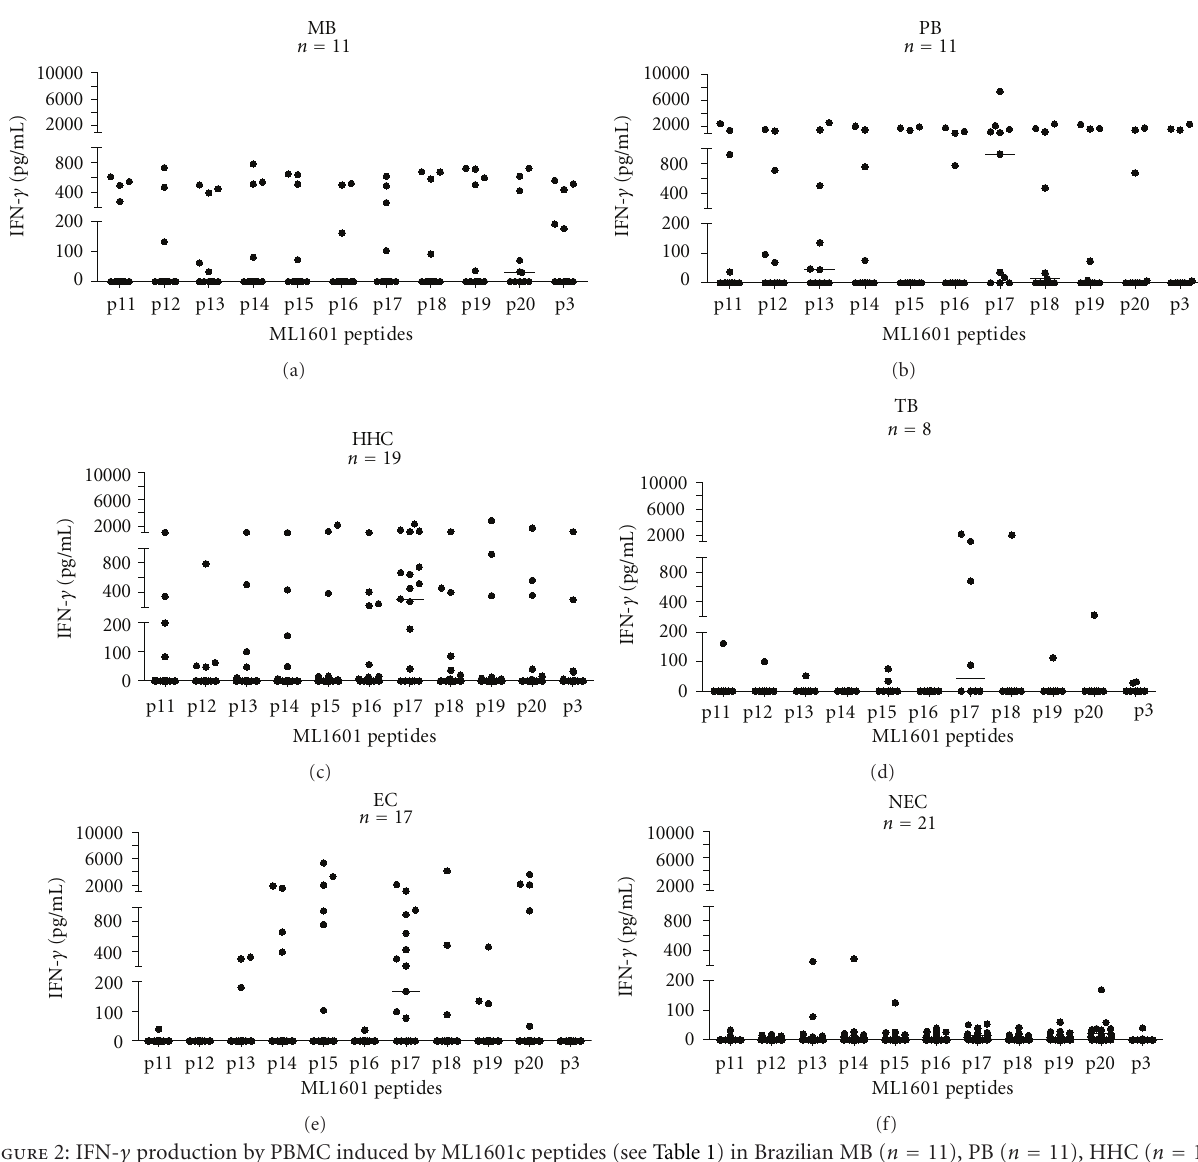
Figure 2: IFN- γ production by PBMC induced by ML1601c peptides (see Table 1) in Brazilian MB ( n = 11), PB ( n = 11), HHC ( n = 19), TB ( n = 8), and EC ( n = 17) as well as Dutch NEC ( n = 21). Values were corrected for background values. All background values were typically < 20pg/mL. Horizontal bars indicate median